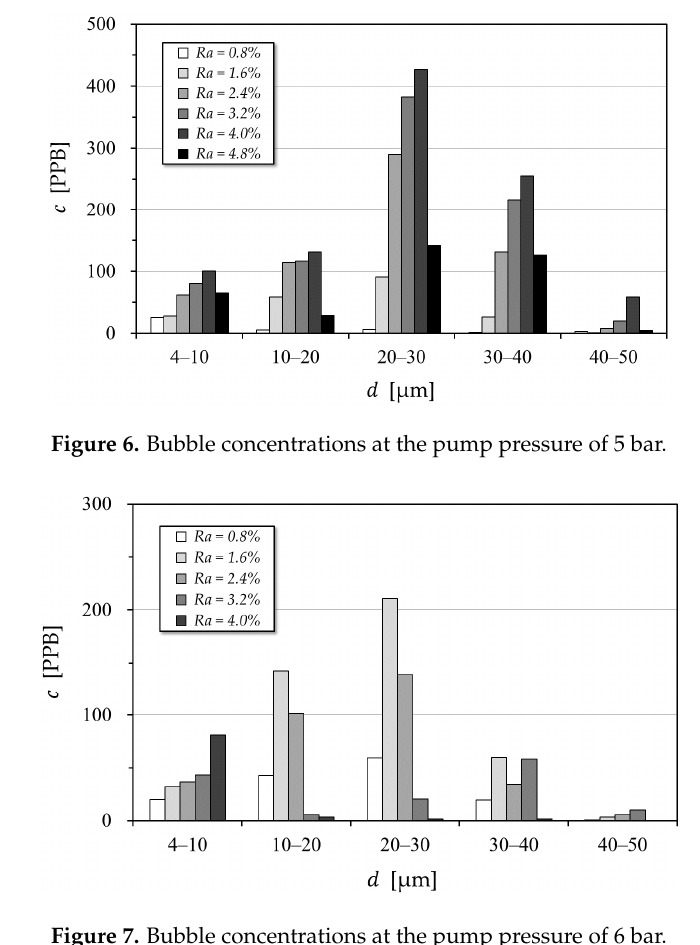
Figure 7. Bubble concentrations at the pump pressure of 6 bar.